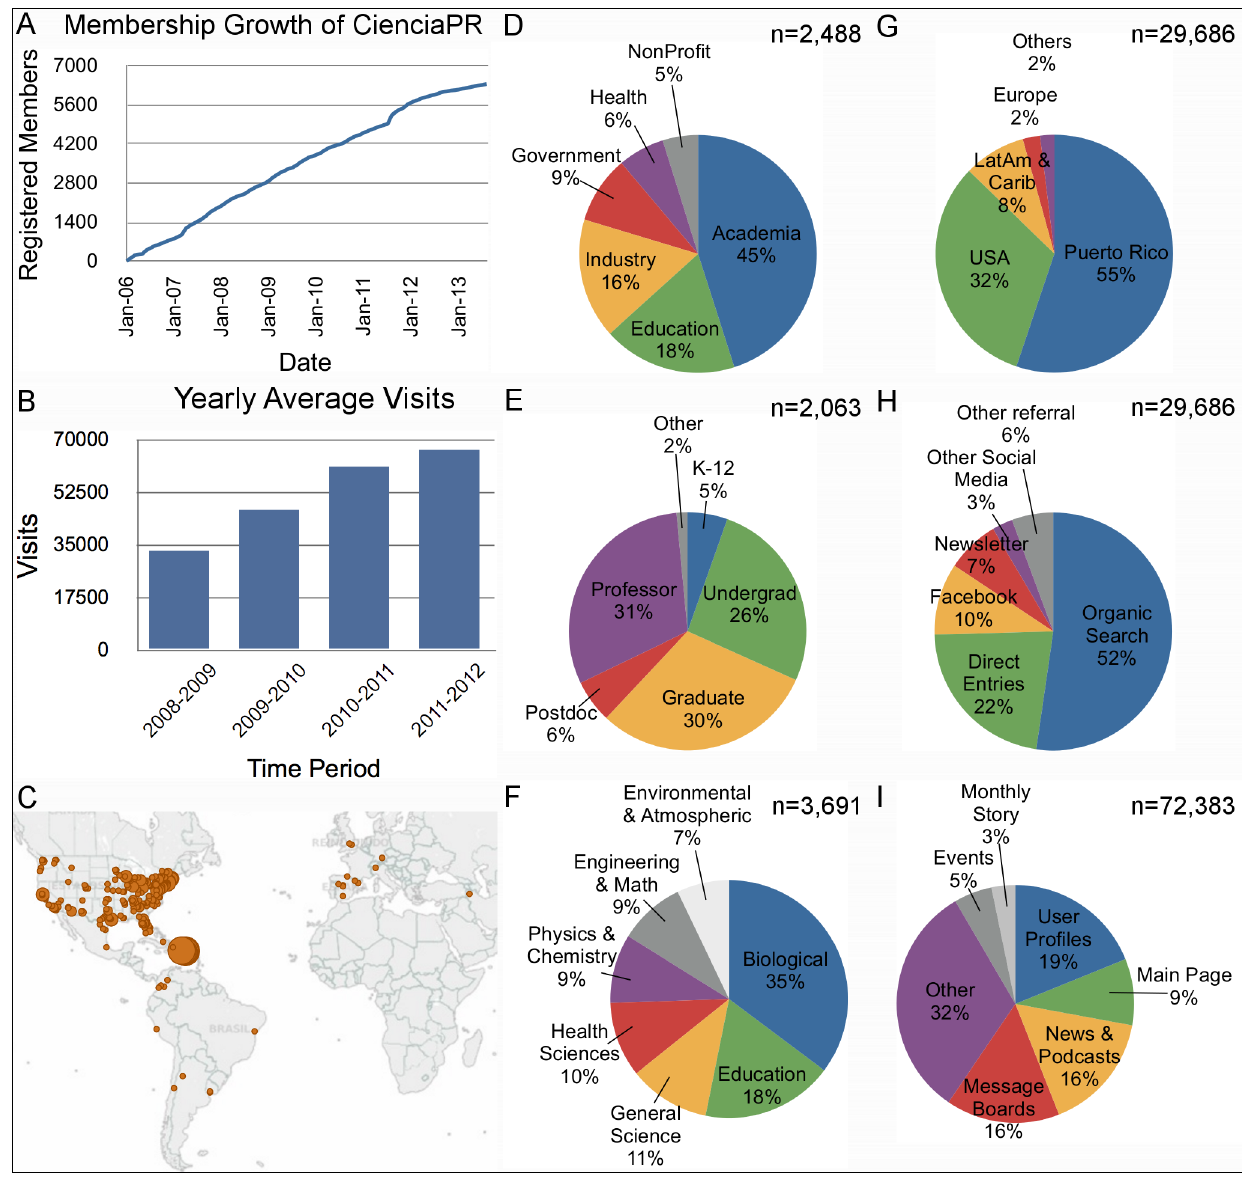
Figure 1. CienciaPR website use and member characteristics. (A) Number of members who have registered with CienciaPR since 2006. (B) Average yearly visits to CienciaPR.org, from October 2008–September 2012, based on Webalizer data. CienciaPR switched to GoogleAnalytics after September 2012. (C) Map representation of CienciaPR members’ geographic dispersion (portion of map is cropped for display purposes). CienciaPR members are in 48 countries, 47 states (not including the territory of Puerto Rico), and over 185 universities in the US. Map made with Tableau Public (D–F) Distribution of members based on (D) work sector, (E) training stage, and (F) broad scientific discipline of interest. Not all members indicated this information on their profiles. Percentages are based on total number of respondents (n). Data as of September 8, 2013. (G–I) Recent CienciaPR website activity from June 1, 2013–August 31, 2013 based on Google Analytics for (G) website visits by geographic region, (H) website visits by source, and (I) page views by website section. Percentages are based on (n), total number of visits (G,H) or pageviews